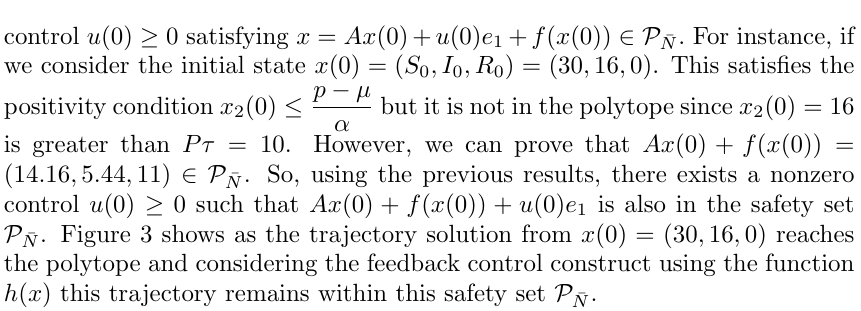
control u (0) ≥ 0 satisfying x = Ax (0) + u (0) e 1 + f ( x (0)) ∈ P ¯